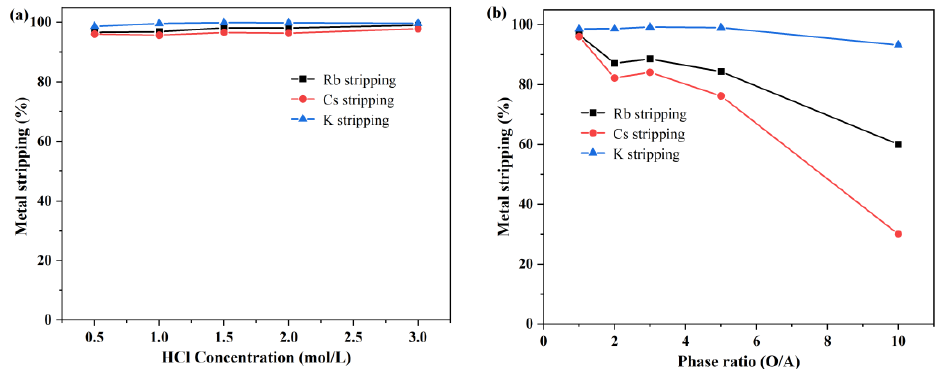
Figure 5. Effect of ( a ) the HCl concentration and ( b ) the O/A ratio on the stripping rates of K, Rb, and Cs.